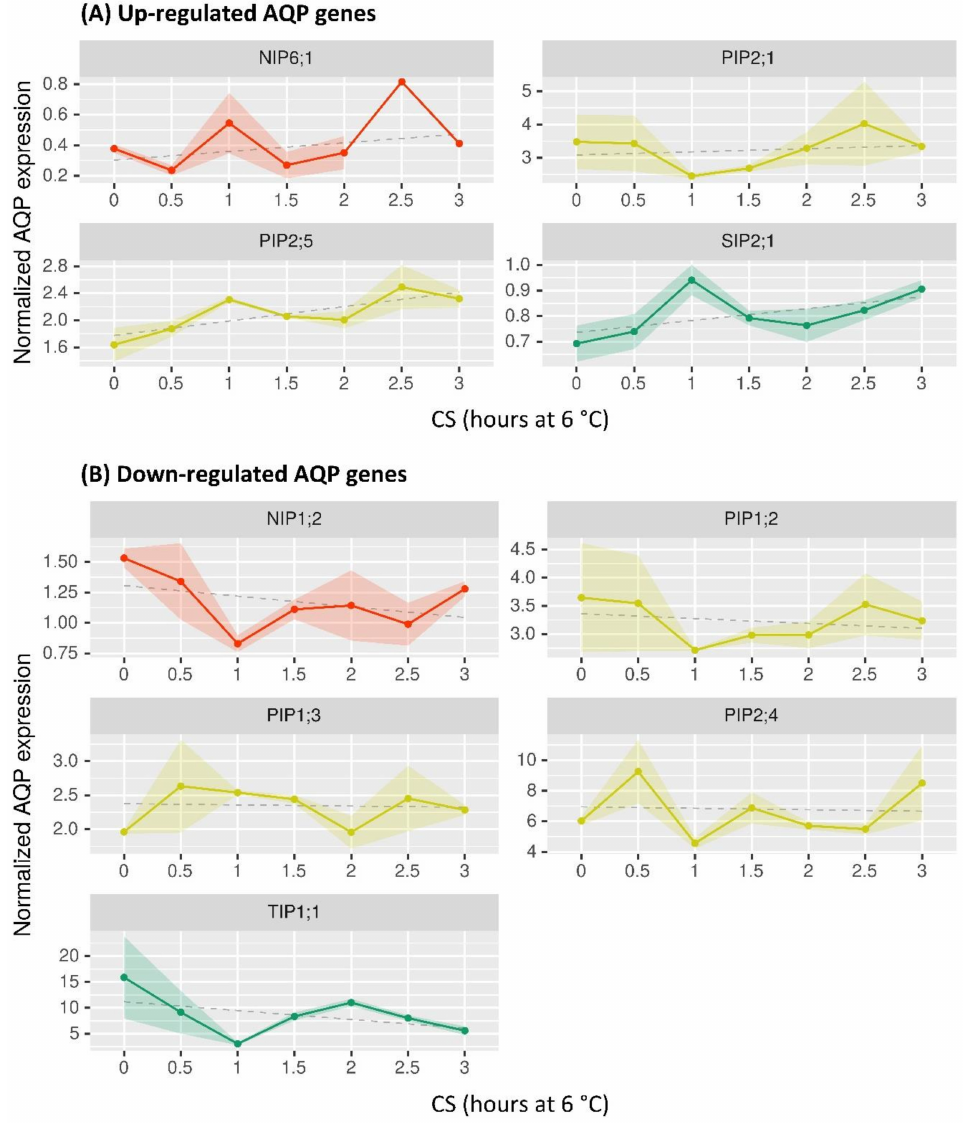
Figure 3. Early transcriptional expression profiles of the BpeAQP genes from Betula pendula leaves in response to cold stress (6 ◦ C). The BpeAQPs are color-coded by subfamily. Data are represented by normalized expression level as a function of CS at 6 ◦ C duration in hours. ( A ) Group of up-regulated AQPs in leaves; ( B ) Group of down-regulated AQPs. The grouping is based on the linear trend (dashed line) estimated by modelization using all time points. PIP, plasma intrinsic protein; TIP, tonoplast intrinsic protein; NIP, nodulin-like intrinsic protein; and SIP, small basic intrinsic